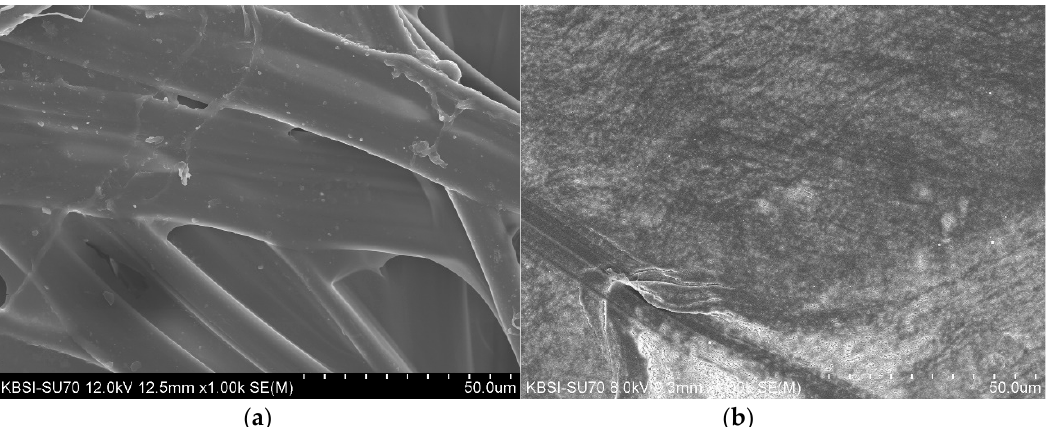
Figure 3. SEM images of patch materials: ( a ) 4-HR-incorporated silk patch and; ( b ) polytetrafluoroethylene (PTFE) patch.